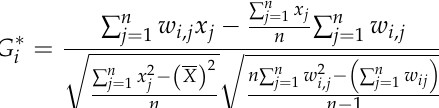
( c ) Figure 7. Distribution of Hangzhou’s thermal environment during the three periods in the typical periods: ( a ) 1984; ( b ) 1998; ( c ) 2020.